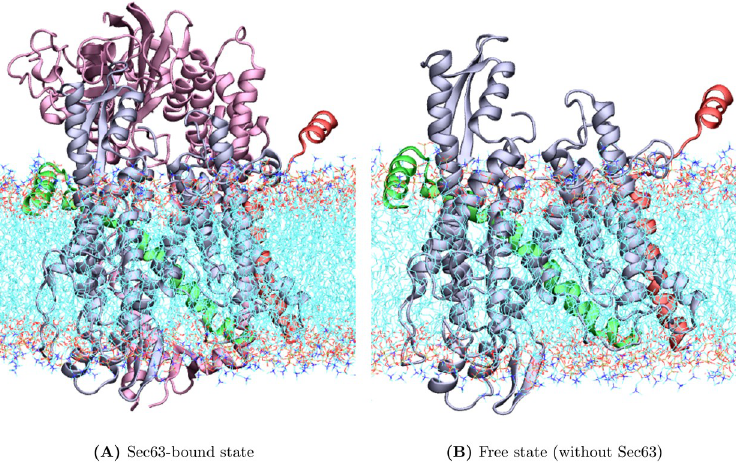
Fig 1. Initial conformations of the molecular dynamics simulations for (A) Sec63-bound state; and (B) free state without Sec63. Sec61, Sss1, Sbh1 and Sec63 are shown in ice-blue, green, red and mauve, respectively, with “New Cartoon” model. The regions populated by lipid molecules are marked using the “line” method. Water and ion molecules are omitted for clarity. The image was generated using VMD-1.9.4.